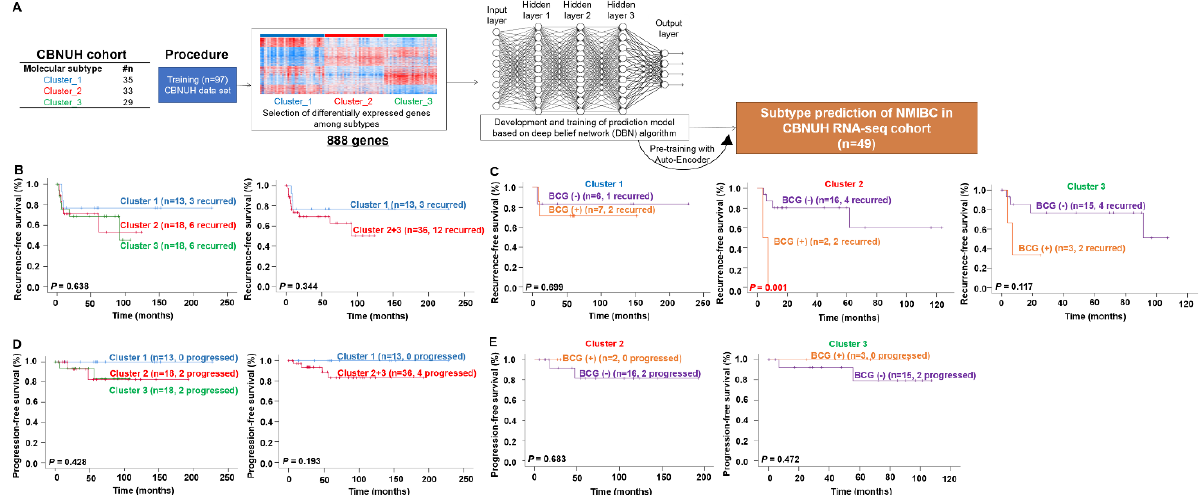
Figure 1. Construction of the MSP888 classifier and validation of its prognostic value in a CBNUH RNA − seq cohort. ( A ) Validation strategy used to construct a prediction model based on the CBNUH RNA − seq cohort. Recurrence − free survival ( B ) and progression − free survival ( D ) of NMIBC patients are predicted by different clusters. The ability of the MSP888 classifier to predict recurrence ( C ) or progression ( D ) after BCG treatment in three subgroups. Patients in Cluster 2 ( E ) derived significant benefit from BCG treatment. Data were plotted according to whether patients received BCG ther- apy. BCG, Bacillus Calmette − Guérin; CBNUH, Chungbuk National University Hospital; MSP888, a molecular signature − based subtype predictor comprising Cluster 1 (EP, equivocal prognosis), Clus- ter 2 (REC.BCG+, related to recurrence and response to BCG treatment), and Cluster 3 (DP.BCG+, related to progression and response to BCG treatment).